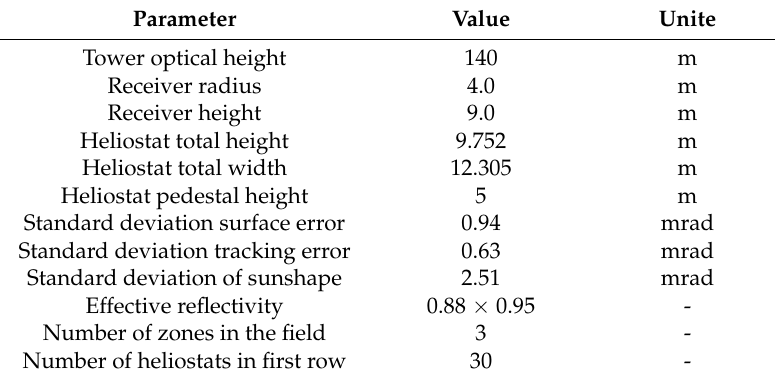
Table 1. Main parameters of heliostat used.